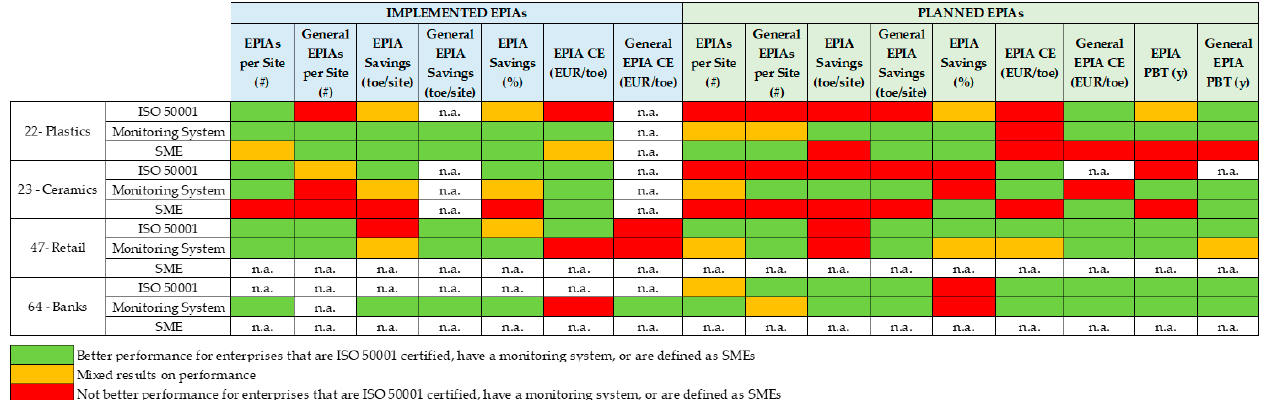
Figure 10. Impact of EnMS, monitoring, and SME class in implemented and planned EPIAs.